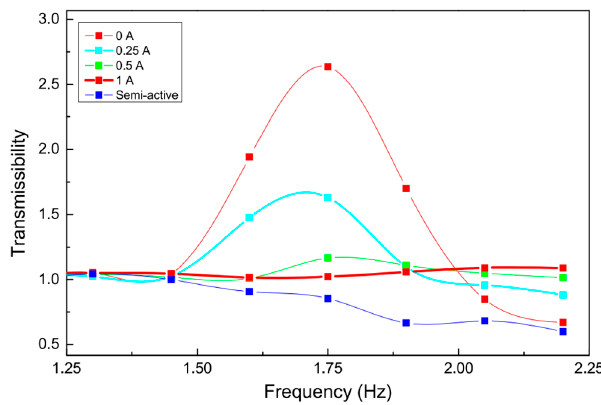
Figure 9. The experimental results of the transmissibility of the seat with MR damper [80].